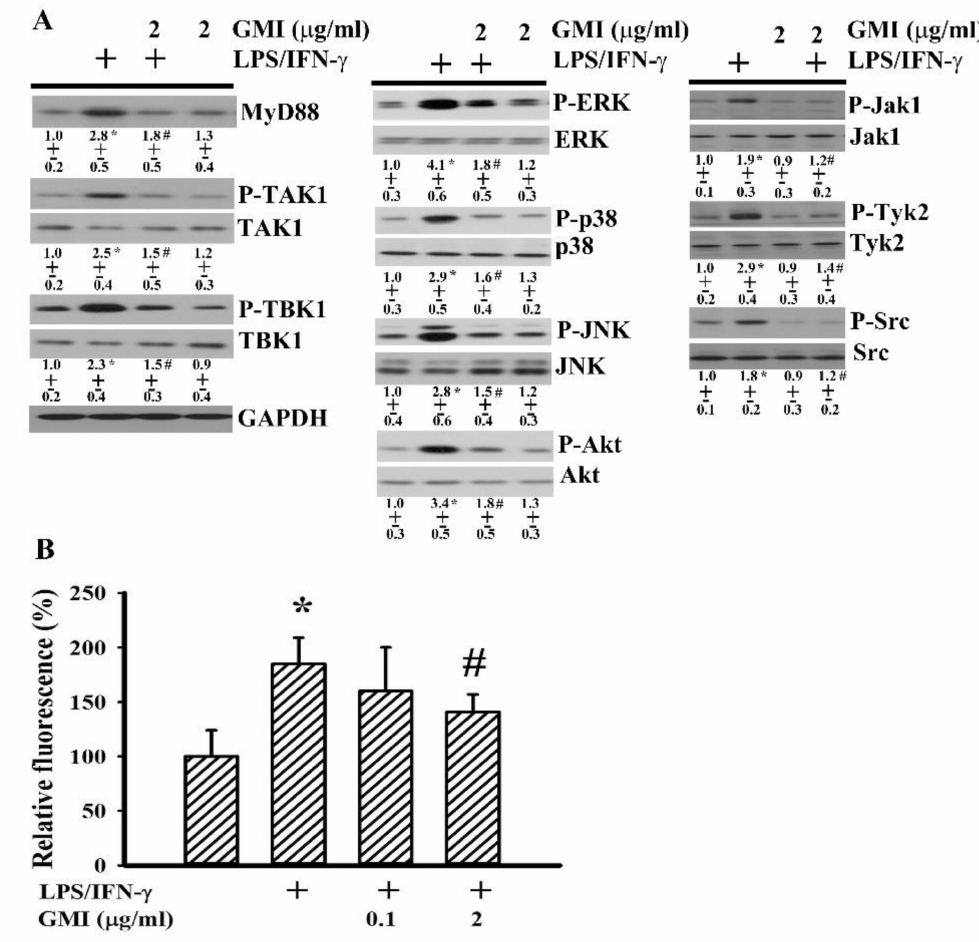
Figure 9. GMI alleviated intracellular signaling molecule activation. Neuron/glia cultures were pretreated with vehicle or various concentrations of GMI (0.1 and 2 µ g/mL) for 30 min. before being incubated with LPS (100 ng/mL)/IFN- γ (10 U/mL) for an additional 4 h. Total cellular proteins were extracted and subjected to Western blot analysis with indicated antibodies ( A ). One representative blot of four independent culture batches is shown and the fold of relative protein content is depicted under the blots. The protein content of untreated control was defined as 1.0. The levels of intracellular free radicals were measured by the oxidation of 2 (cid:48) , 7 (cid:48) -Dichlorodihydrofluorescein Diacetate (H2DCFDA) ( B ). The fluorescent signal of untreated control was defined as 100%. * p < 0.05 vs. untreated control and # p < 0.05 vs. LPS/IFN- γ control, n = 4. The + means the groups treated with LPS/IFN- γ and the rest groups without + indicate vehicle